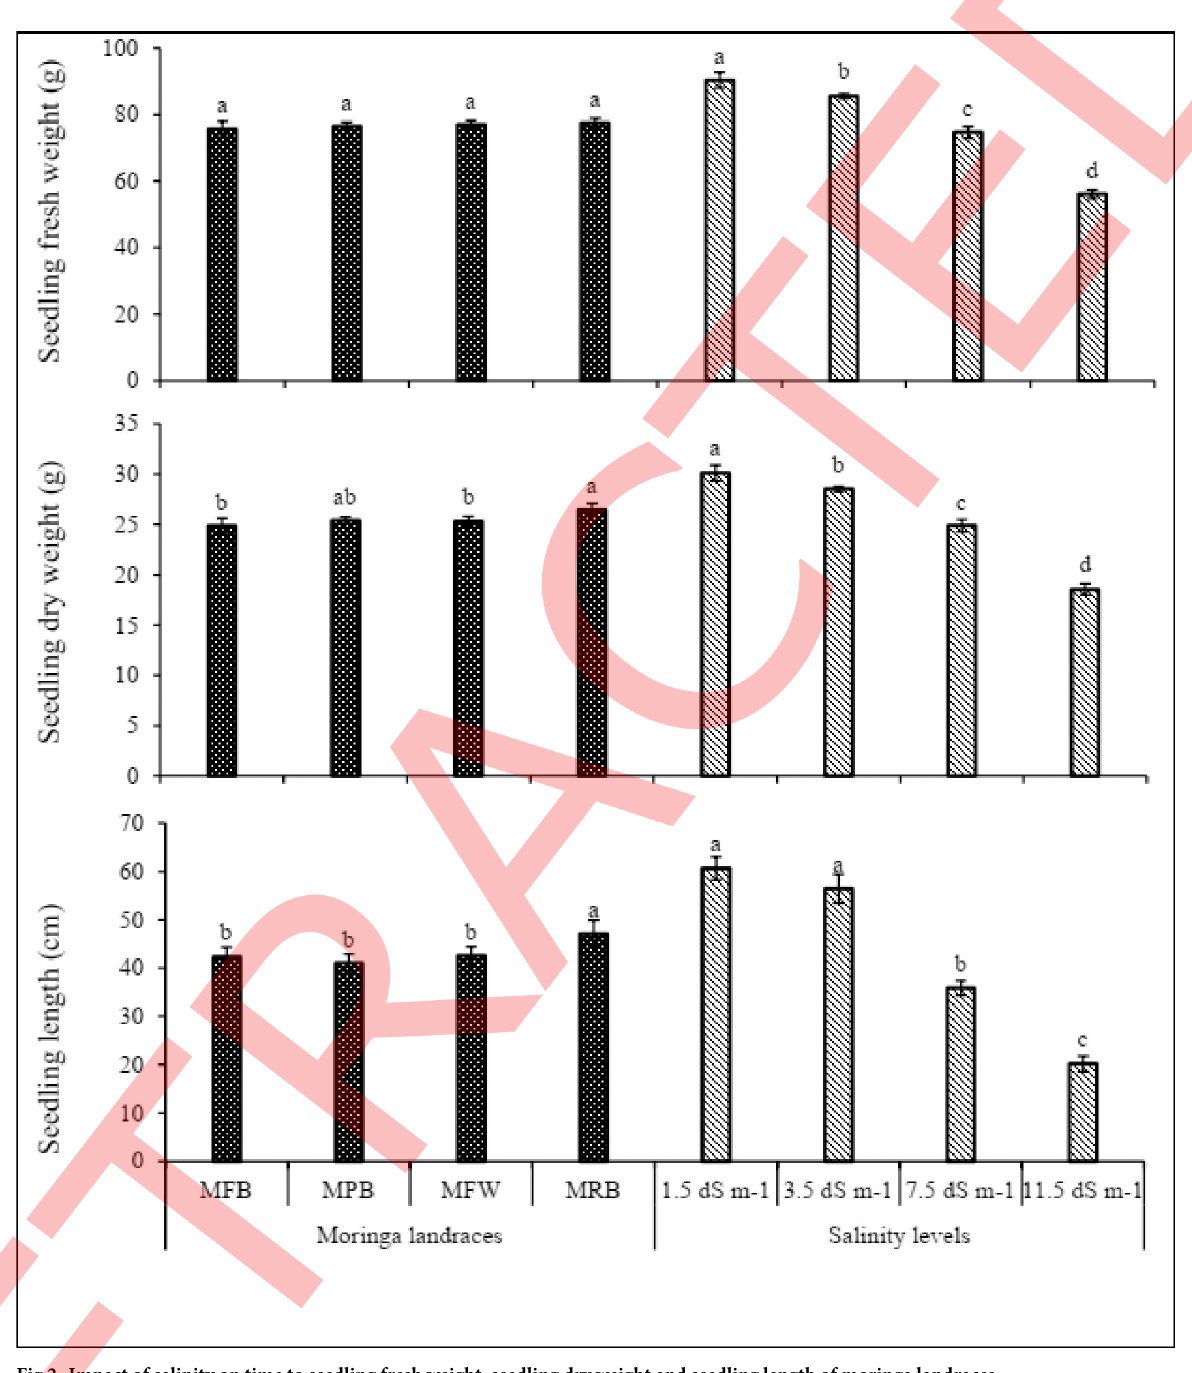
Fig 2. Impact of salinity on time to seedling fresh weight, seedling dry weight and seedling length of moringa landraces.